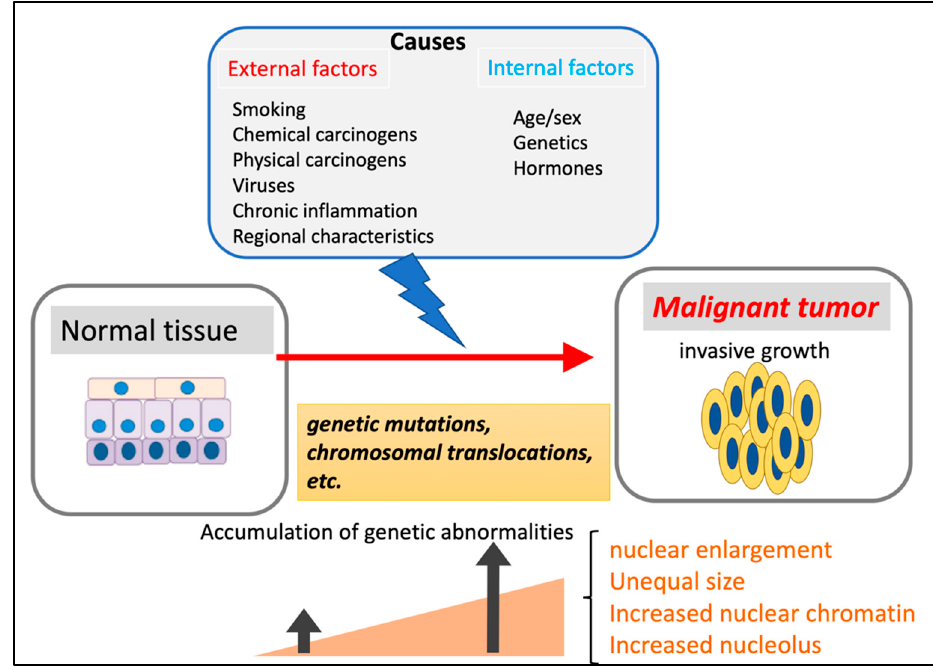
Figure 2. Cancer is triggered by a variety of factors. Cancer is caused by genetic changes in normal tissues, either by congenital factors or by factors acquired through exogenous stimulation.